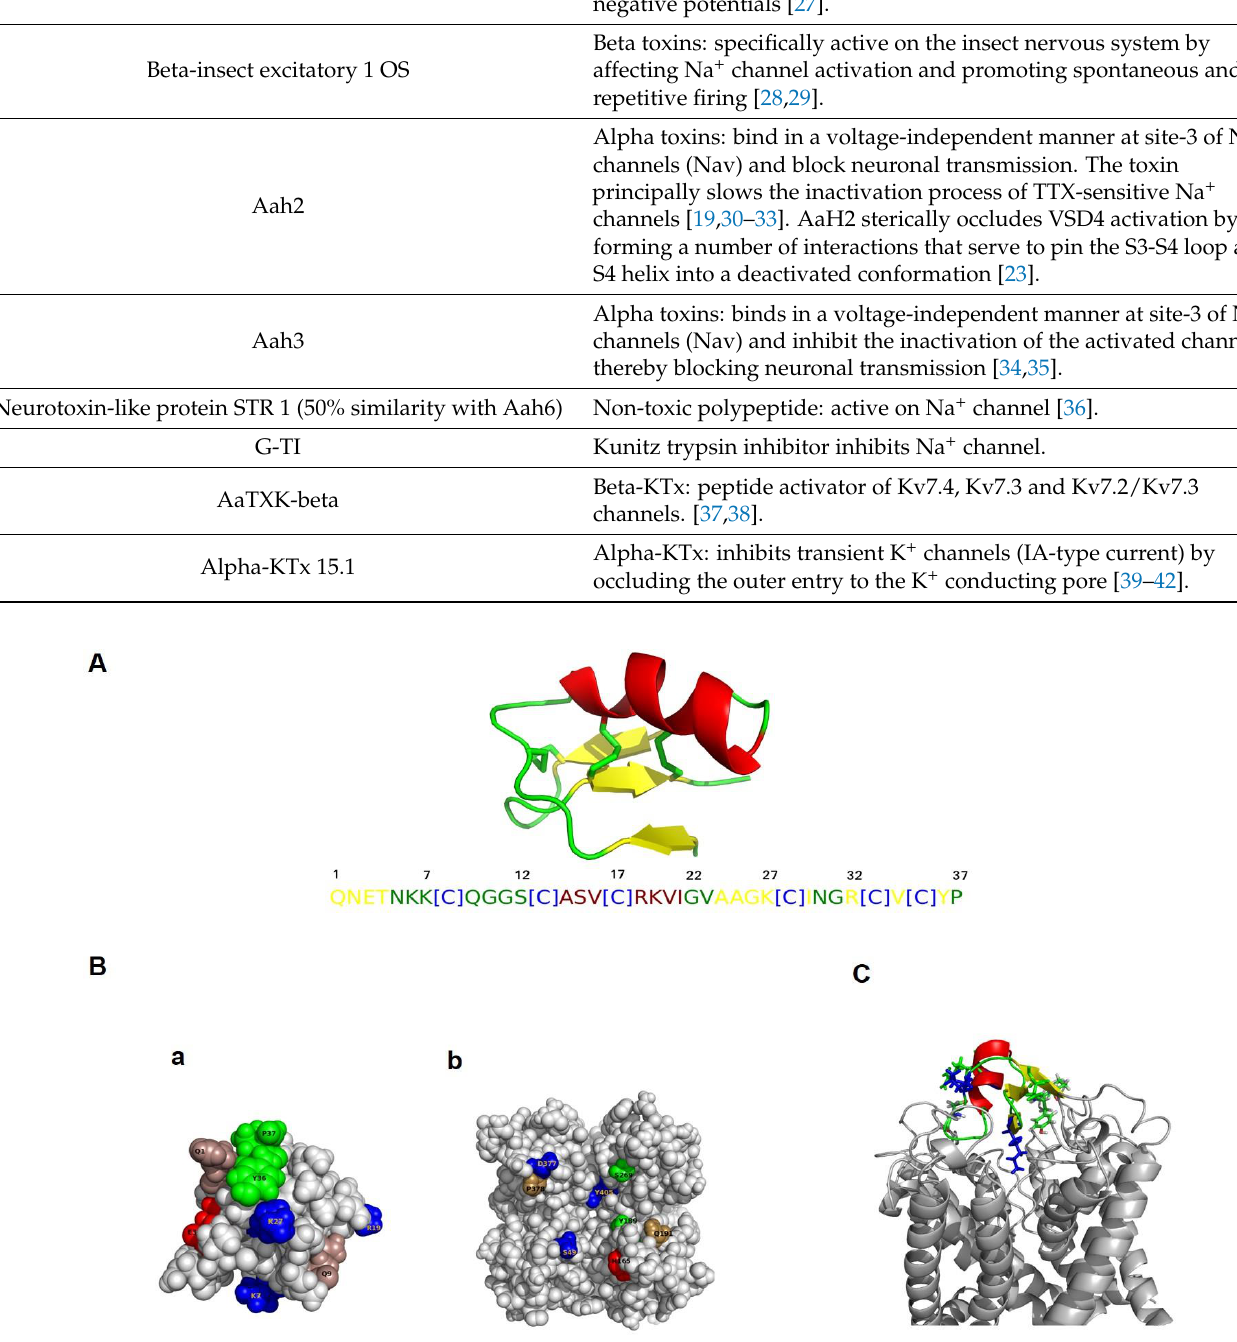
Figure 6. Molecular modeling of alpha-KTx 15.1 and Kv3.1 channel interactions. ( A ) 3-D structure model of alpha-KTx 15.1 adopts the common Csαβ fold that allows the molecule to have a stable three-dimensional conformation. alpha-KTx 15.1 sequence (37 amino acids), alpha-helix coloured in red, beta sheet in yellow, cysteine residues in green. ( B ) Hot spot amino acids (coloured) implicated in the interaction between alpha-KTx 15.1 ( a ) and Kv3.1 channel ( b ). ( C ) Docking complex of alpha-KTx 15.1/Kv3.1 showing that the beta sheet of the toxin interacts with the selectivity filter residues of the channel. The pore is physically blocked with the K27 lateral chain of alpha-KTx 15.1.